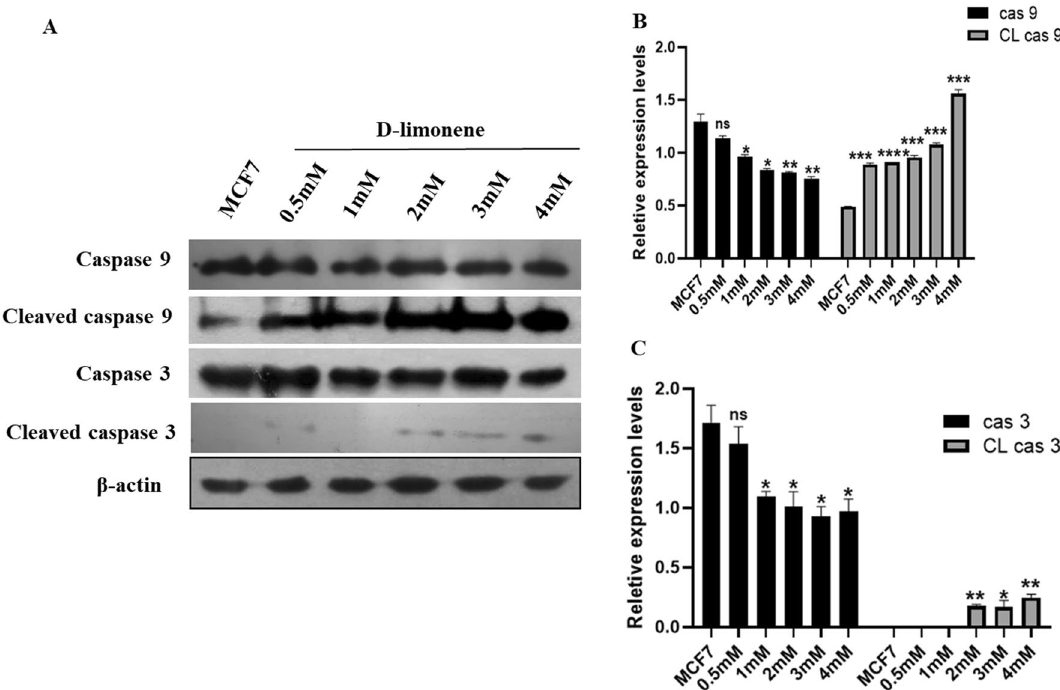
Figure 4. d-limonene regulates the apoptosis related protein in MCF7 breast cancer cells. ( A ) Expression pattern of molecules relevant to apoptosis detected by western blotting. ( B & C ) shows the relative expression levels of caspases and cleaved caspases. Data expressed as the mean ± SD from three independent experiments where * P -value ≤ 0.05, ** P ≤ 0.01 and*** P ≤ 0.001 as compared to MCF 7 cells